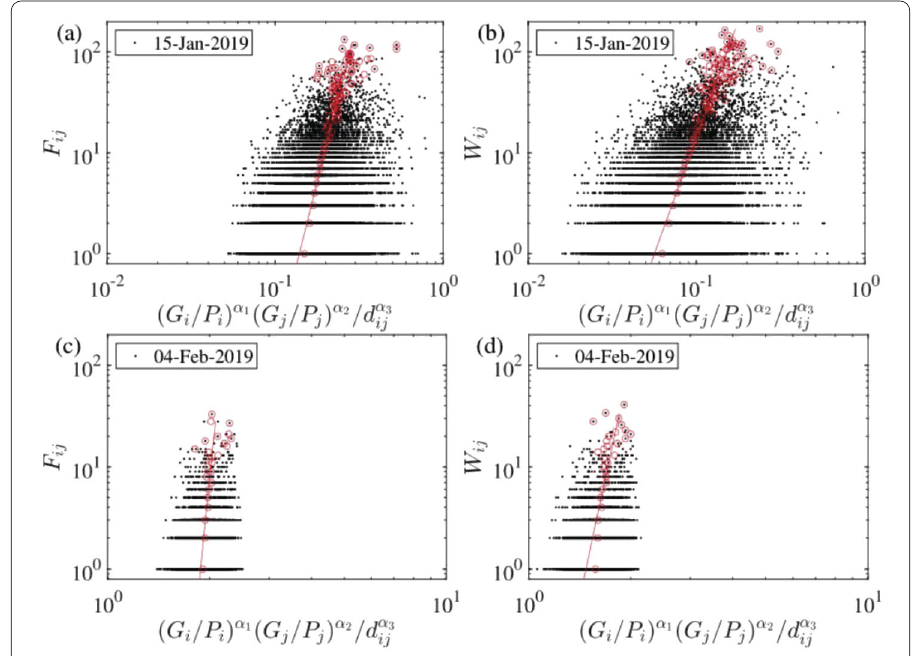
Figure 20 Testing the modified gravity law with per capita GDP for the daily directed and undirected freight highway transportation networks. ( a ) The directed network on 15 January 2019. ( b ) The directed network